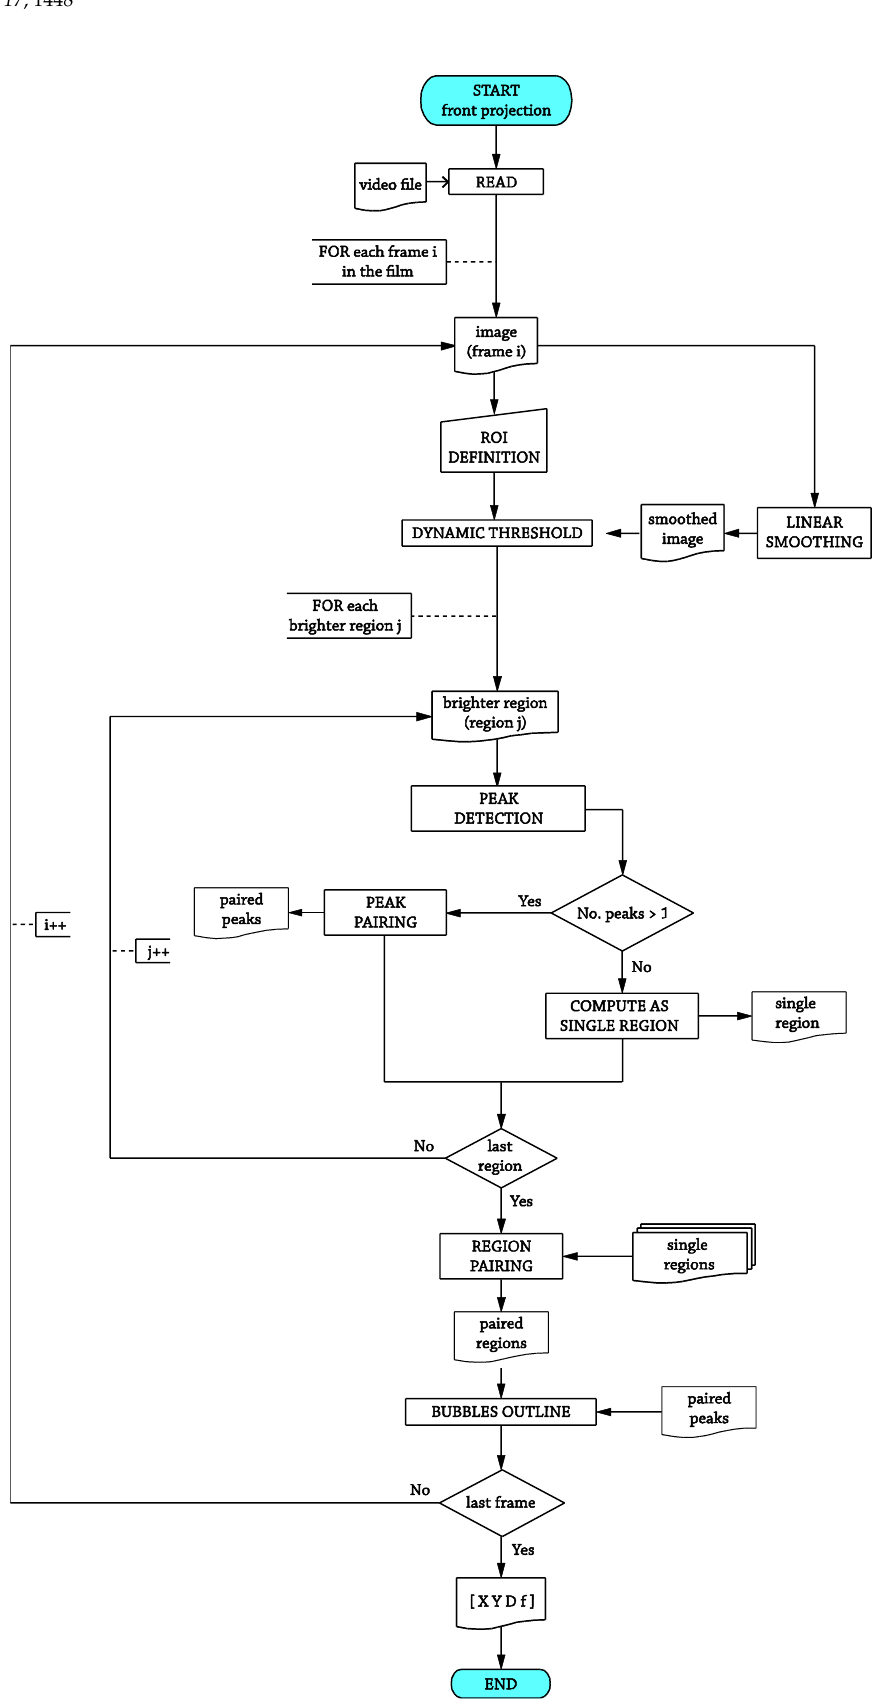
Figure 2. Flowchart for the front projection optical recognition.